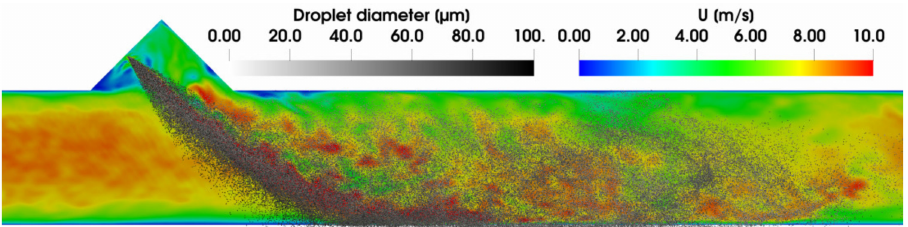
Figure 11. Injection and resulting spray dynamics in configuration C1: jet injection, evaporating spray convection by turbulent cross-flow, droplet–wall interaction, film formation and transport.